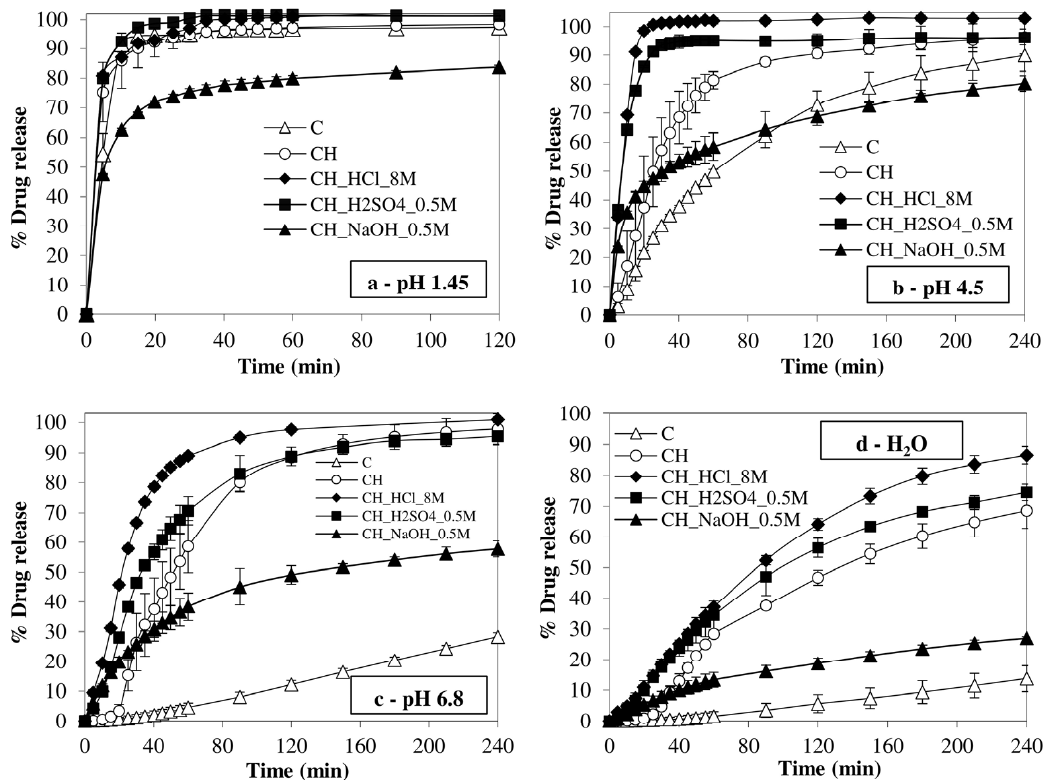
Figure 11. Dissolution profiles of C, CH, CH_HCl_8M, CH_H 2 SO 4 _0.5M, and CH_NaOH_0.5M at pH 1.45 ( a ) according to USP monograph, in which the drug is more soluble; at pH 4.5 ( b ), simulating gastric fed conditions; pH 6.8 ( c ), simulating intestinal environment and deionized water ( d ).